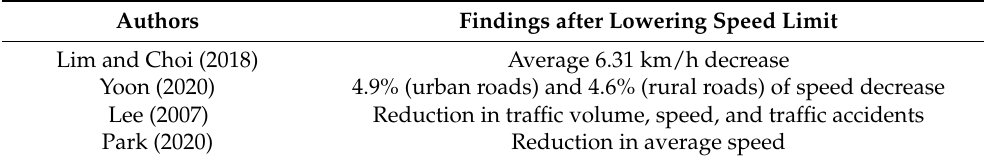
Table 1. Summary of previous